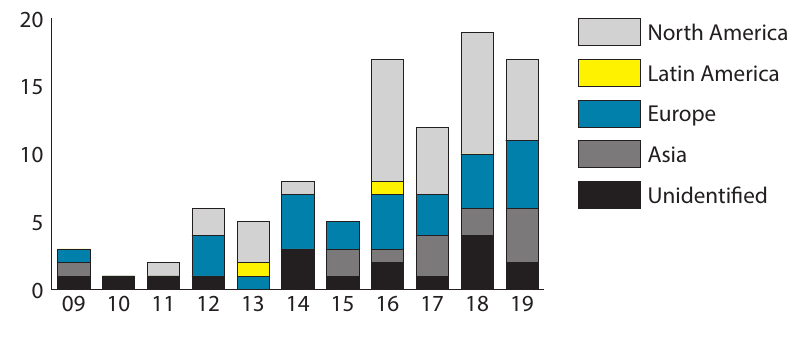
Figure 2. Frequency of publications per year.